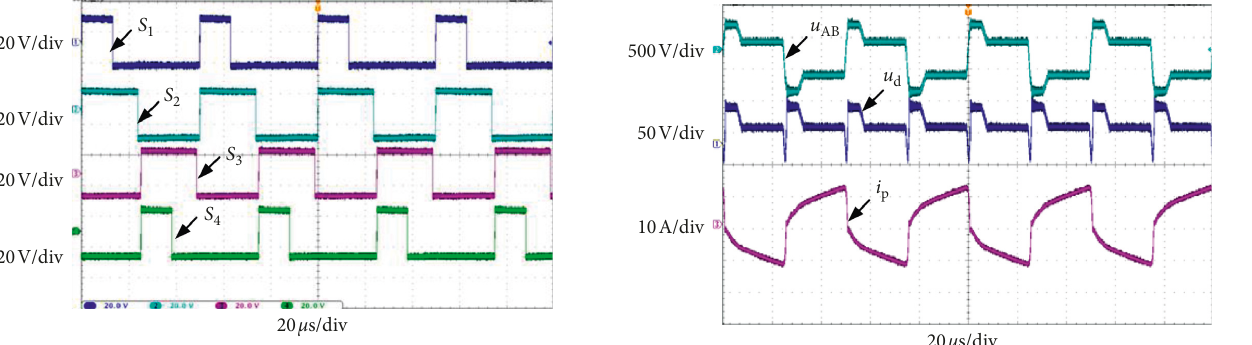
Figure 18: Driving waveforms of full-bridge three-level controlled- source circuit.